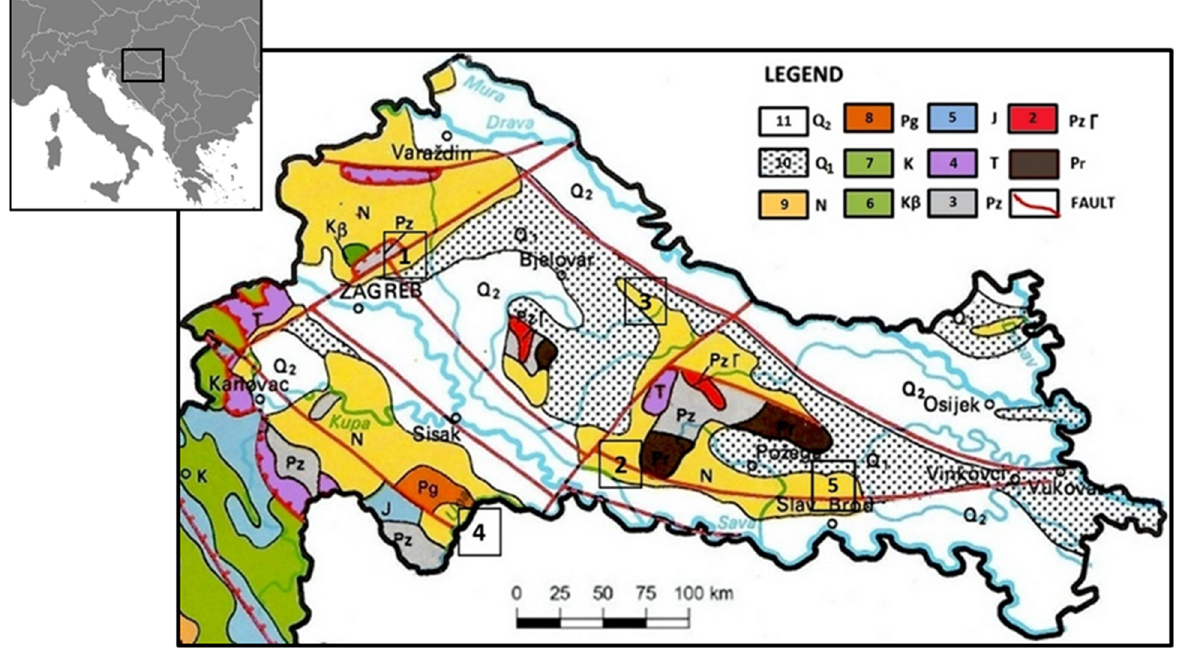
Figure 3. Geological map of northern and north-eastern Croatia (modified after [55]) which was, during the Miocene, flooded by the Paratethys Sea. Paratethyan deposits are marked with yellow, and faults with red color. Legend: 1. Precambrian metamorphic rocks; 2. Paleozoic granites; 3. Paleozoic sedimentary rocks; 4. Triassic carbonates, sporadically clastites; 5. Jurassic carbonates with scarce volcanoclastites; 6. Cretaceous dominantly carbonate rocks; 7. Cretaceous basalts; 8. Paleogene limestones; 9. Neogene clastic and carbonate rocks; 10. Pleistocene, dominantly unconsolidated clastites; 11. Holocene unconsolidated clastites. Localities mentioned in this study: Medvednica Mt. (1); Sava Depression (2); Drava Depression (3); Kostajnica (4); Dilj (5).